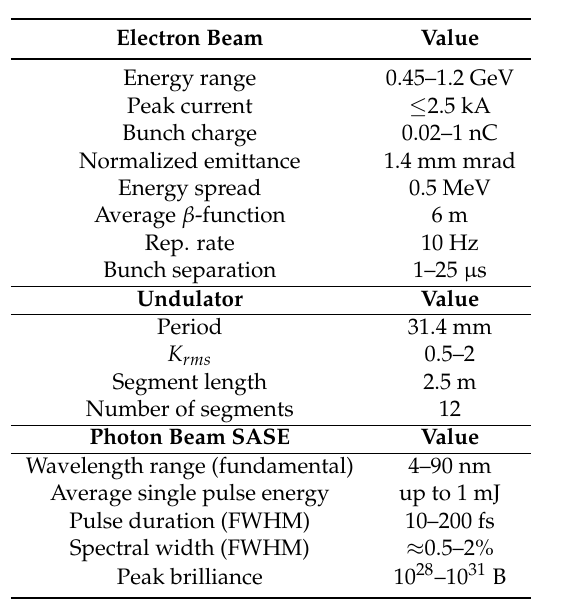
Figure 1. Schematic layout of the FLASH facility. The electron gun is on the left, and the experimental halls are on the right. Behind the last accelerating module the beam is switched between FLASH1, which is the original undulator line, and FLASH2, which has been in operation since 2015. Also shown is sFLASH, the seeding R&D setup in FLASH1 [6] and FLASHForward [7], which is a plasma wakefield experiment in the FLASH3 beamline under construction planned to start operation at the end of 2017. FEL: free-electron laser. Table 1. Parameters for FLASH2. SASE: self-amplified stimulated